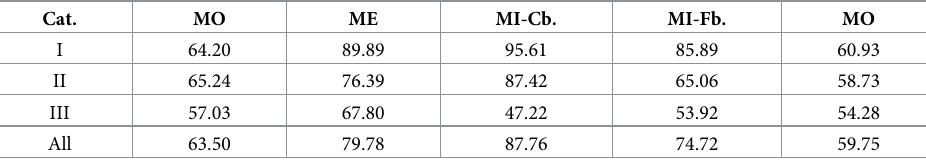
Table 2. Inside performance of each run averaged by category. Cat. MO ME MI-Cb.